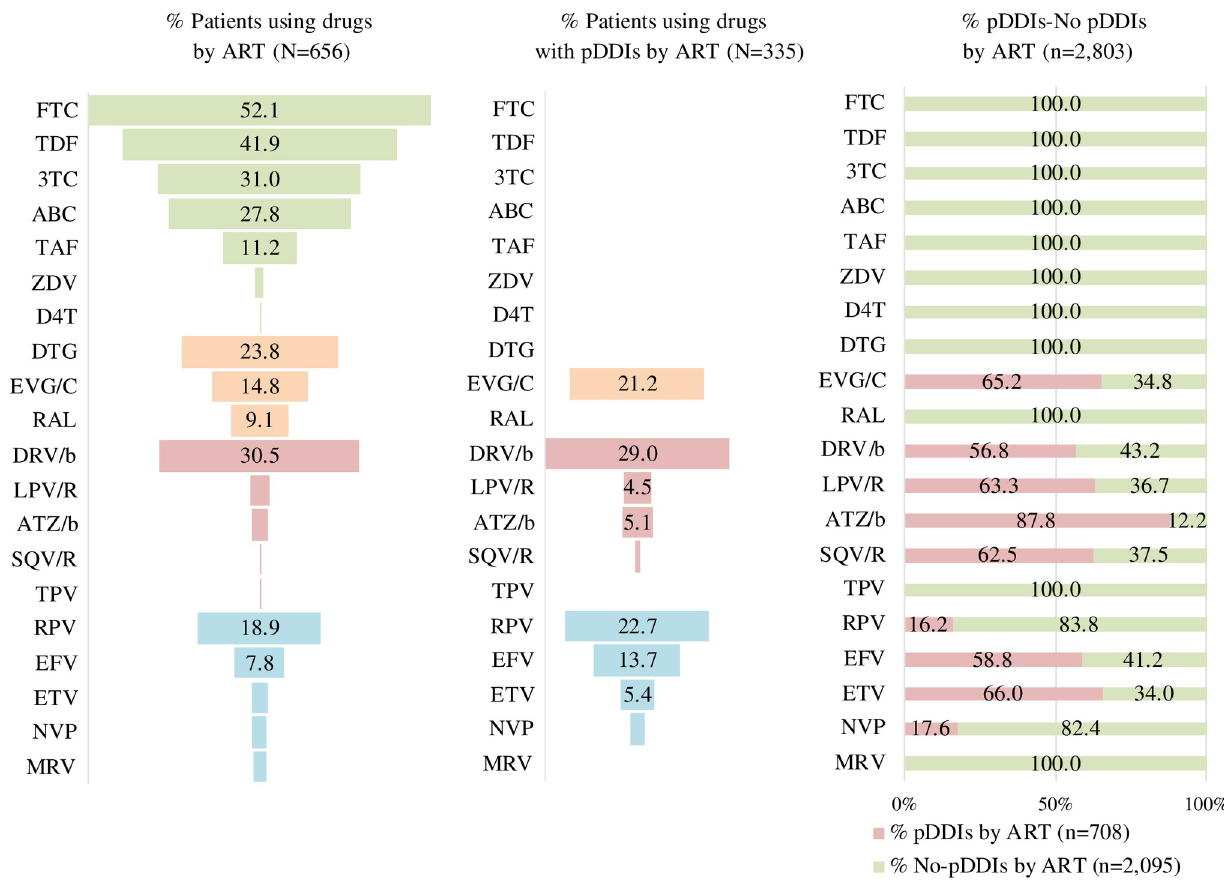
Fig 4. Prevalence of participants using drugs, with potential interactions and distribution per type of antiretroviral therapy. 3TC: Lamivudine; ABC: Abacavir; DTG: Dolutegravir; FTC: Emtricitabine; RPV: Rilpivirine; TDF: Tenofovir fumarate; TAF: Tenofovir alafenamide; EVG/C: Elvitegravir/ cobicistat; EFV: Efavirenz; D4T: Stavudine; DRV/b: Darunavir boosted; RAL: Raltegravir; NVP: Nevirapine; TPV: Tipranavir; ETV: Etravirine; LPV/R: Lopinavir/ritonavir; MRV: Maraviroc; ATZ/b: Atazanavir boosted; ZDV: Zidovudine; SQV/R: Saquinavir/ritonavir; ART: Antiretroviral; pDDIs: Potential drug-drug interactions; No pDDIs: No potential drug-drug interaction; N: patients; n: number of pDDIs.